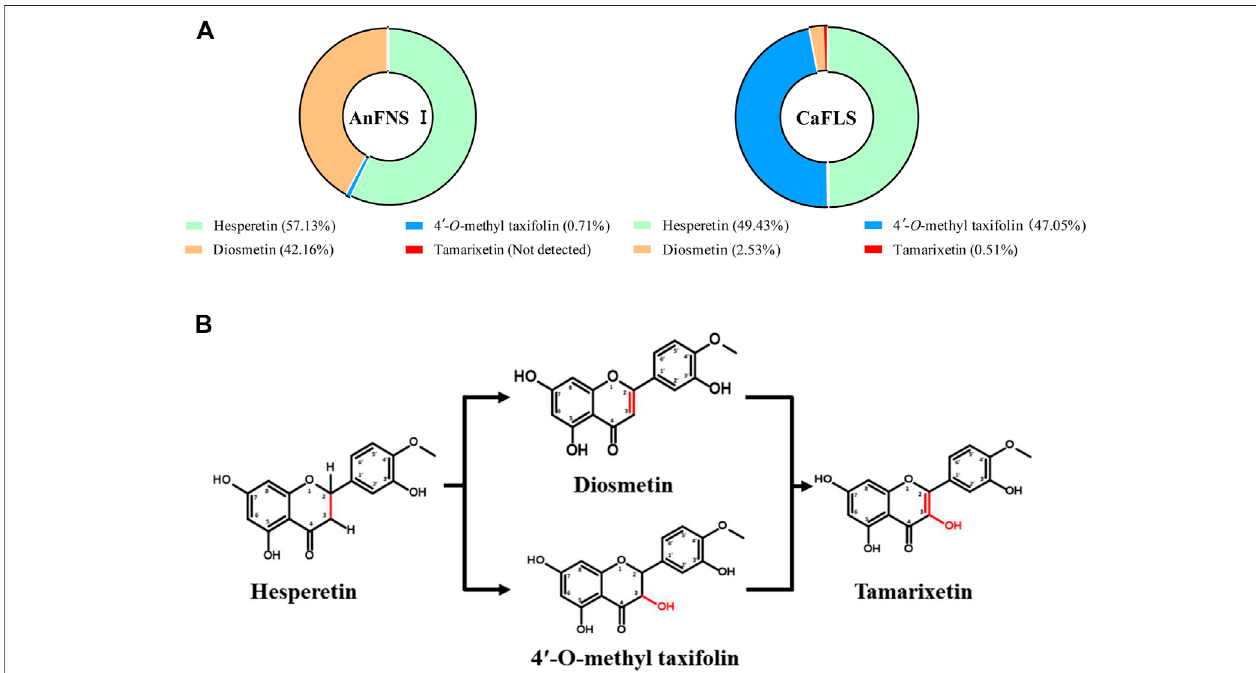
FIGURE 2 | Catalytic products of hesperetin catalyzed by AnFNS I and CaFLS. Note: (A) Proportion of multiple fl avonoids in the catalytic products. (B) Possible formation processes of multiple fl avonoids ( Not detected: Refers to concentrations below the detection limit).